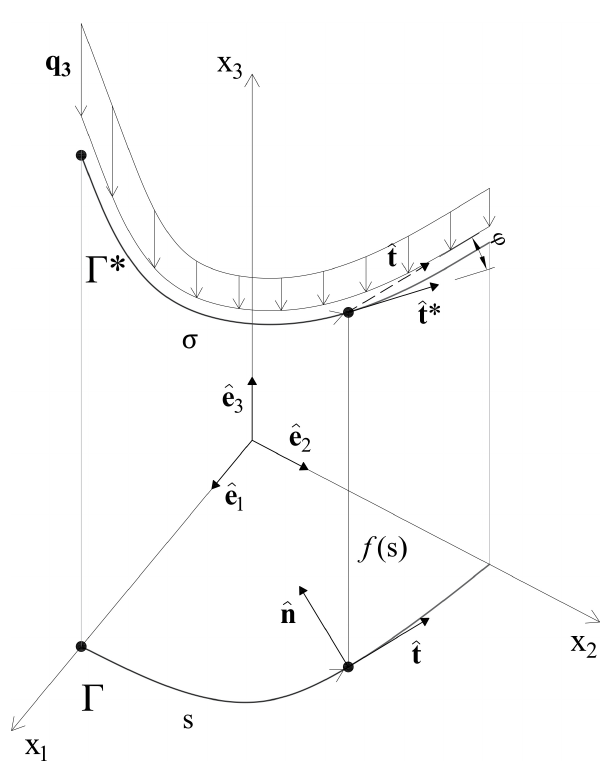
Figure 2. Schematic view of the curve Γ * and its projection Γ on a horizontal